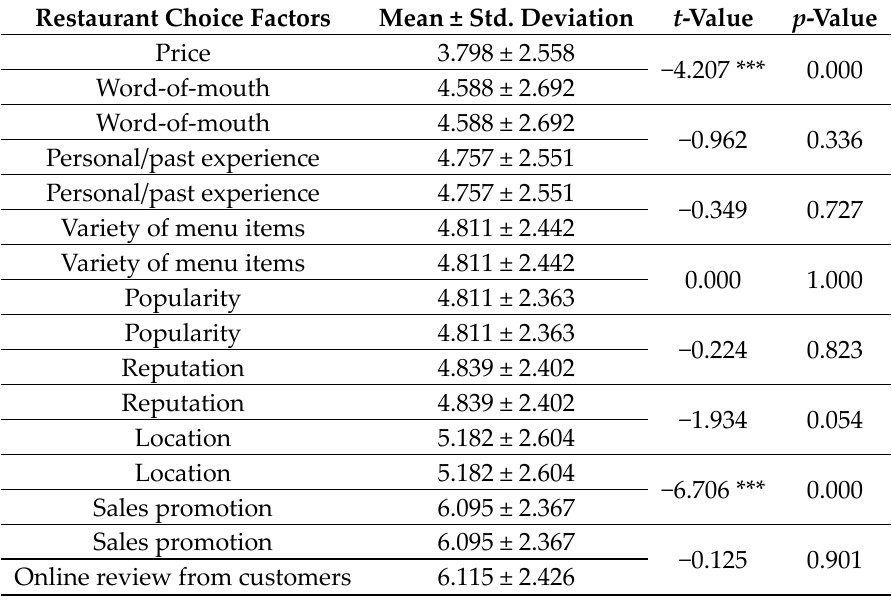
Table 2. Significance of restaurant choice factors